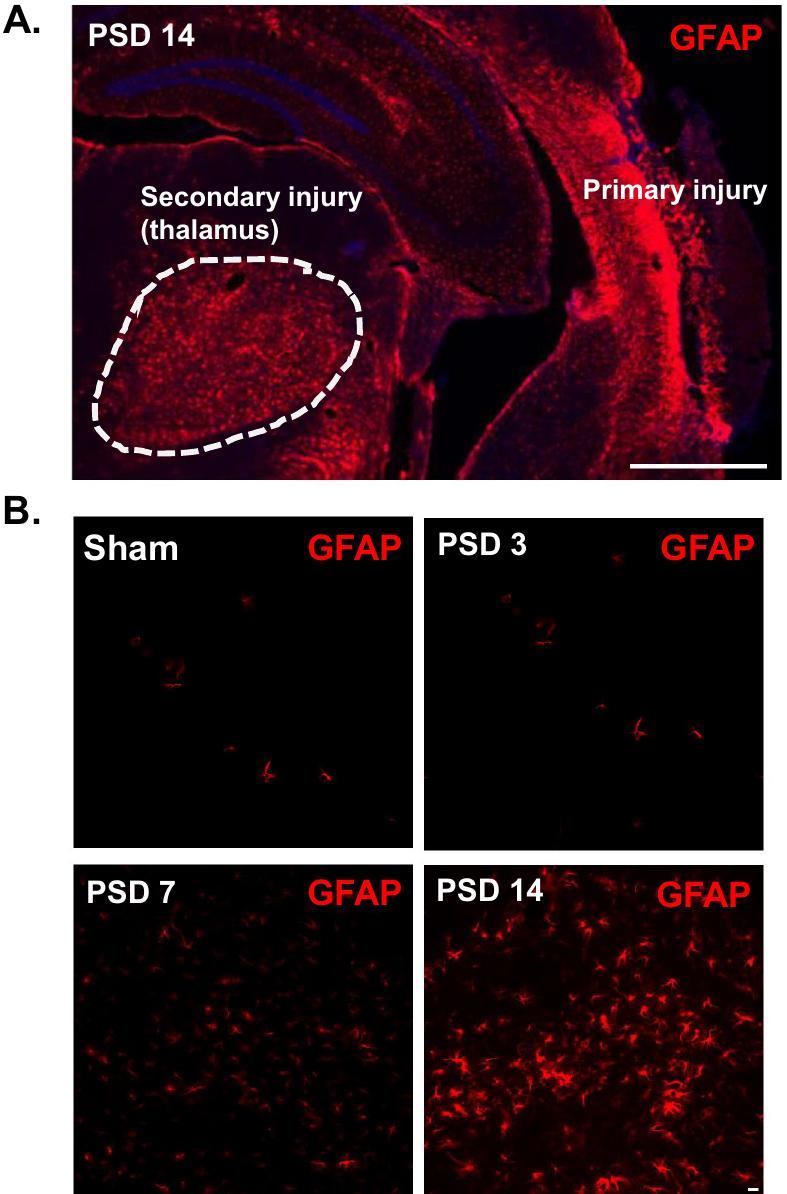
Figure 4. Cortical stroke induces delayed astrogliosis in the ipsilateral thalamus. Cortical infarction was induced in young C57BL/6 J mice. At 3 days, 1 week and 2 weeks after stroke, brains were isolated and sectioned. Immunostaining with anti-GFAP antibody was performed. Brain sections at − 2 mm from bregma were used for the visualization of thalamic astrocyte activation. ( A ) Coronal brain section showing activated astrocytes (GFAP) in the posterior region of the primary injury and in the ipsilateral thalamus at PSD 14. A glial scar is evident in the cortical injury, but not within the thalamus (10X obj, stitched image; scale bar = 1 mm). ( B ) Time course of GFAP staining showing delayed astrocyte activation in the ipsilateral thalamus (20X obj; scale bar = 20